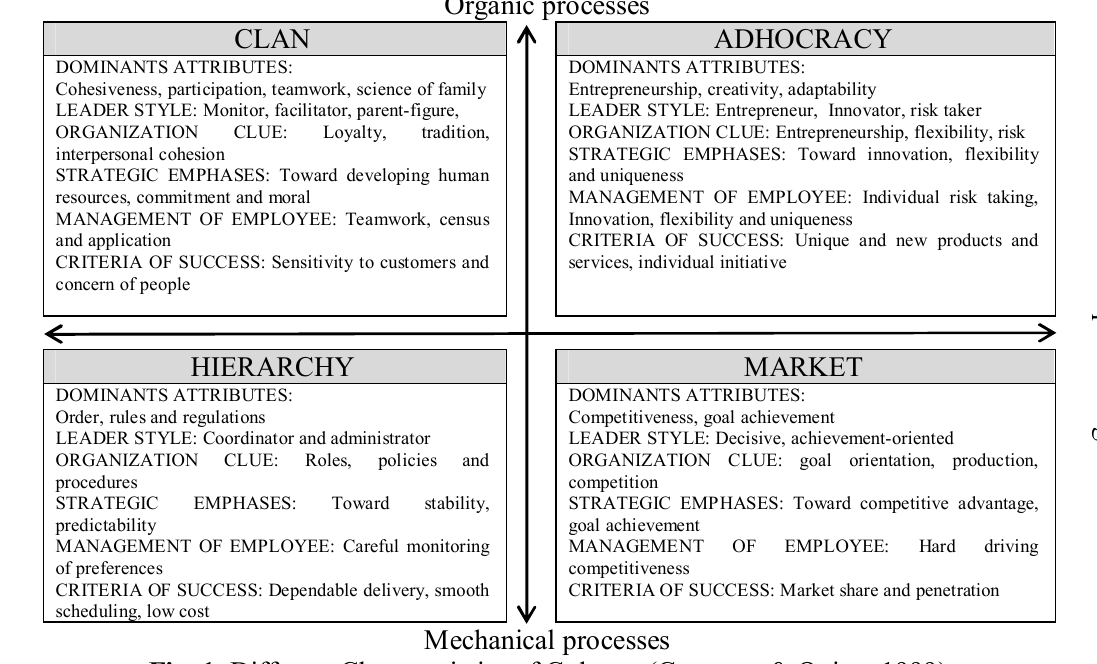
Fig. 1. Different Characteristics of Cultures (Cameron & Quinn,